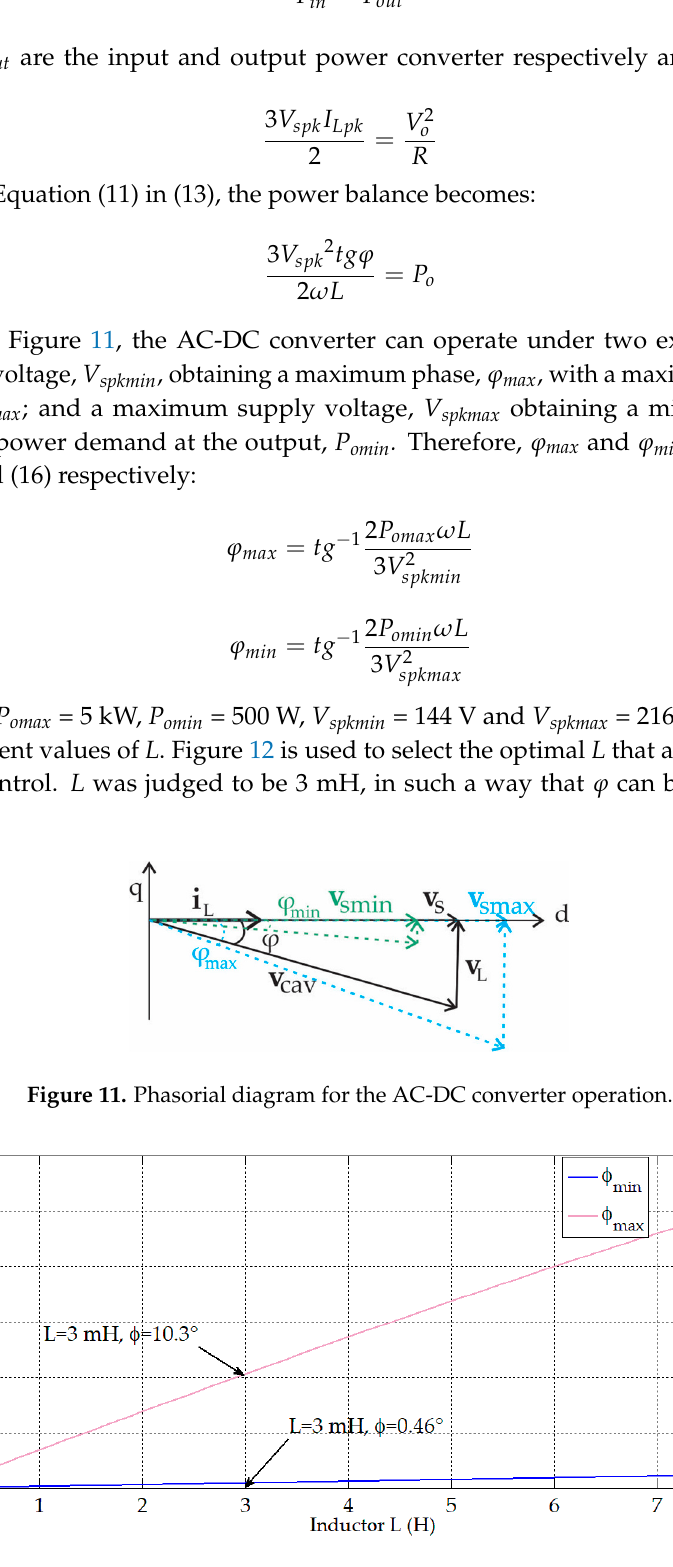
Figure 12. φ min and φ max obtained for different values of L .